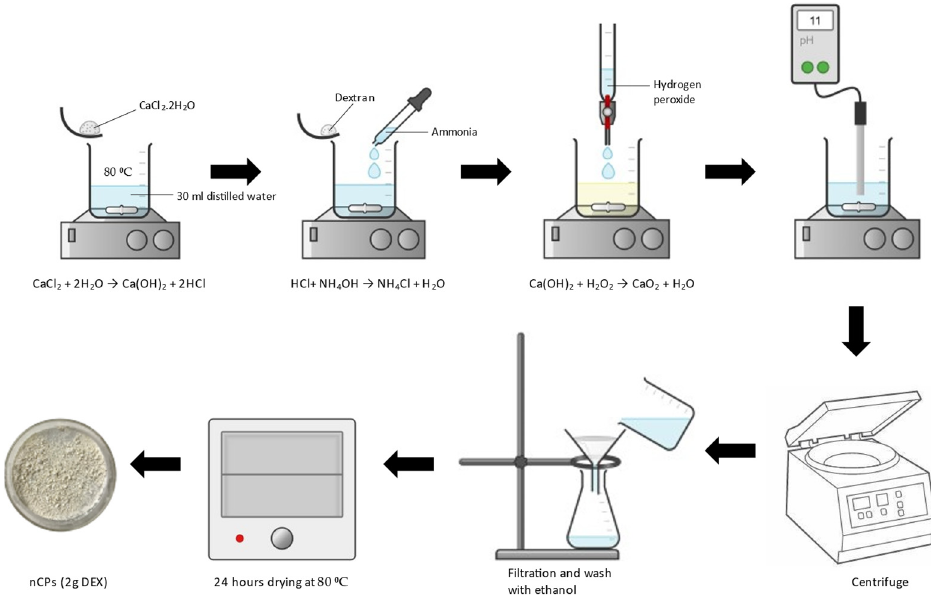
Figure 1. Schematic diagram on synthesis of nCPs with dextran.